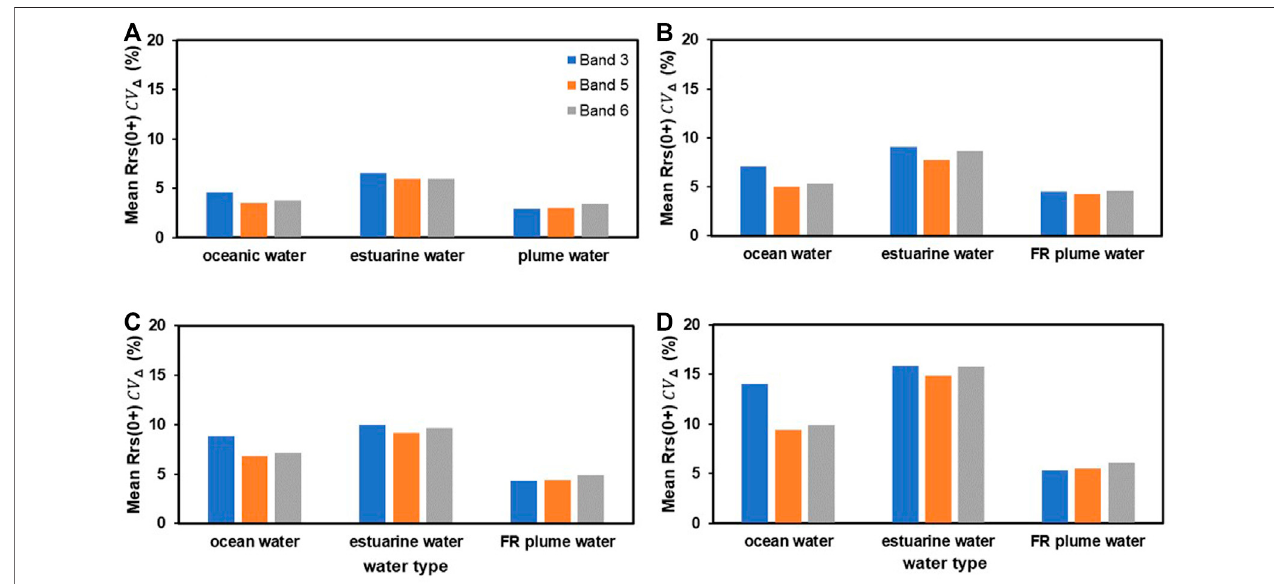
FIGURE 7 | Comparison of mean coef fi cient of variability in remote sensing re fl ectance R rs (0+) (CV Δ ) for oceanic, estuarine, and plume waters with regard to pixel grid resolutions of (A) 300, (B) 900, (C) 1500, and (D) 3000 m for the SoG waters along the cruise track.